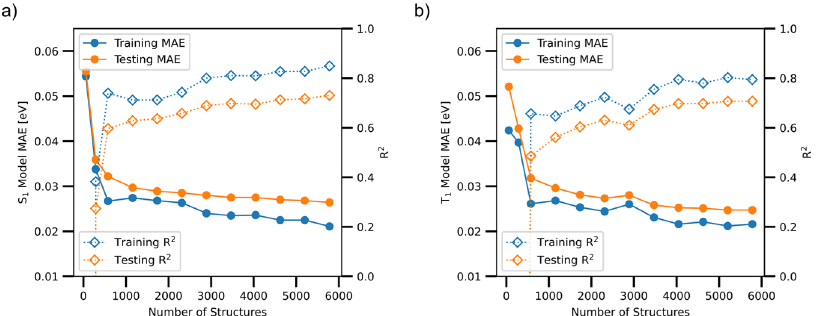
Fig. 4 Learning curves of the machine learning models. Learning curves of the a S 1 and b T 1 machine learning models for a fi xed test set of 1445 structures. The solid lines show the mean absolute error (MAE, left y-axis), while the dashed lines show the coef fi cient of determination ( R 2 , right